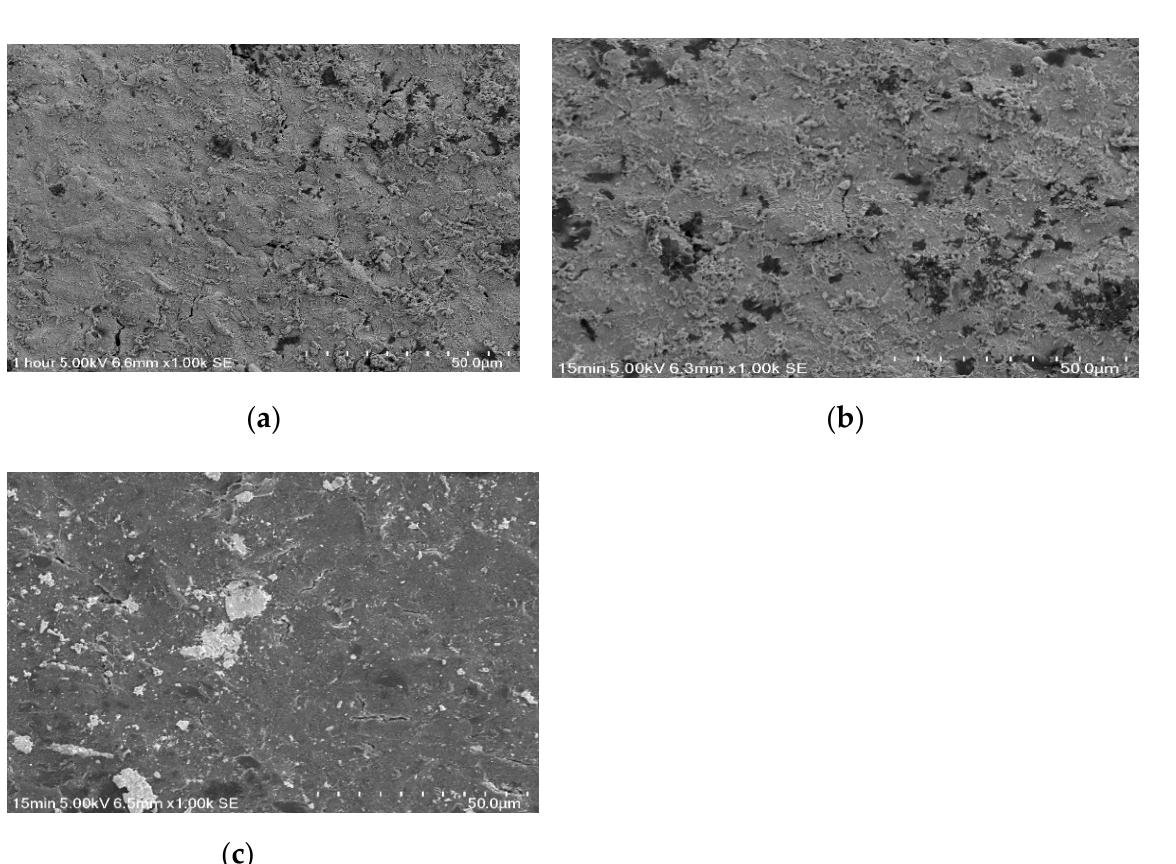
Figure 4. SEM images of TiN films deposited on the glass substrates using different process parameters: ( a ) , TiN surface magnified × 1000 prepared at 9:1 (Ar:N 2 ) gas ratio, ( b ) TiN surface at 10:2 (Ar:N 2 ) gas ratio and ( c ) TiN surface showing smooth morphology prepared at 10:10 (Ar:N 2 ) gas ratio.